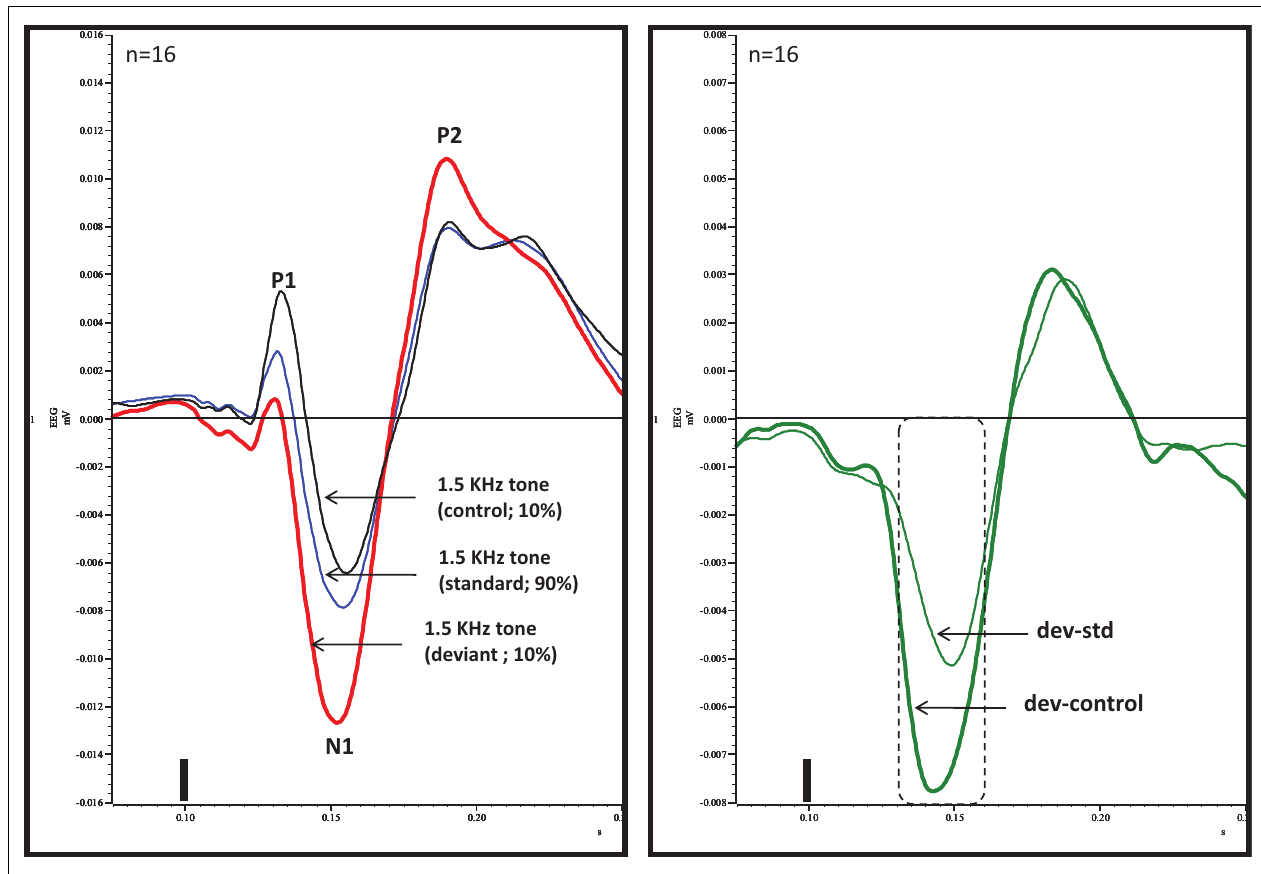
region of 30–60ms after stimulus onset. Only 30–60ms region was significant (Bonferroni corrected P < 0.0125) compared to contiguous 30ms areas ( − 30 to 0, 0–30, and 60–90ms).Tone onset was defined as time 0 and is marked by a vertical bar in this and all other figures that show ERP